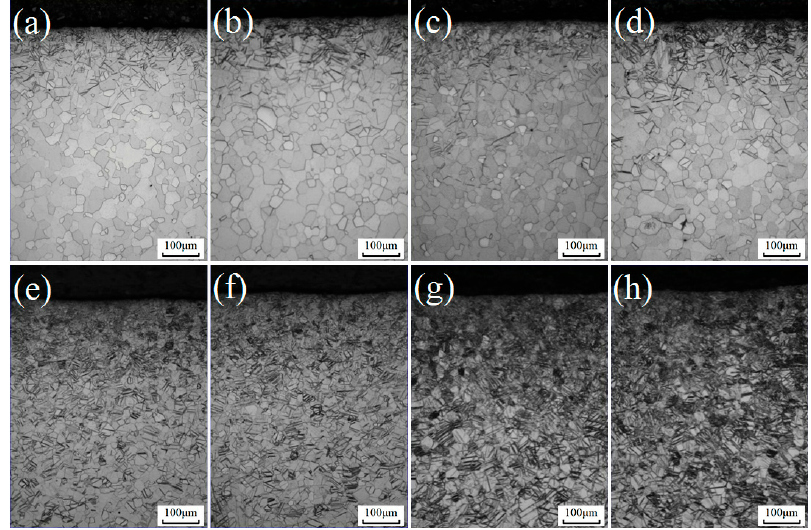
Figure 1. The microstructure evolution induced by MSP at ( a ) 5 min, ( b ) 10 min, ( c ) 20 min, ( d ) 30 min; and SMAT at ( e ) 15 min, ( f ) 30 min, ( g ) 60 min, ( h ) 90 min.